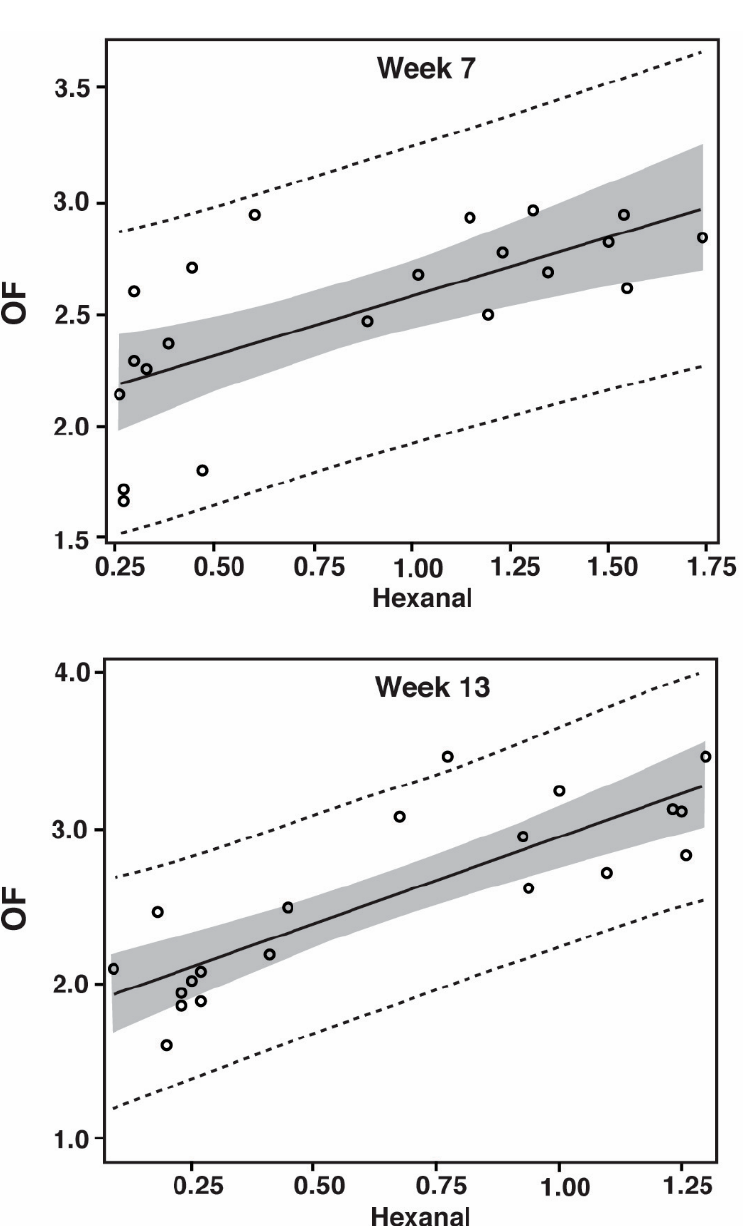
Figure 2. Prediction plot for off-flavor (OF) from headspace hexanal when examining pulled pork at week 1 ( R 2 = 0.338; p = 0.007), week 7 ( R 2 = 0.468; p = 0.001), and week 13 ( R 2 = 0.701; p < 0.0001) of refrigerated storage. Dashed lines provide the 95% prediction limits. The shaded area is the 95% confidence limits of the fit. The finished product was thermally processed and modified atmosphere packaged in 75% N 2 and 25% CO 2 . The off-flavor scale was 0 to 15 with 15 being highest off-flavor. Units for hexanal were mg per kg (weight/weight).